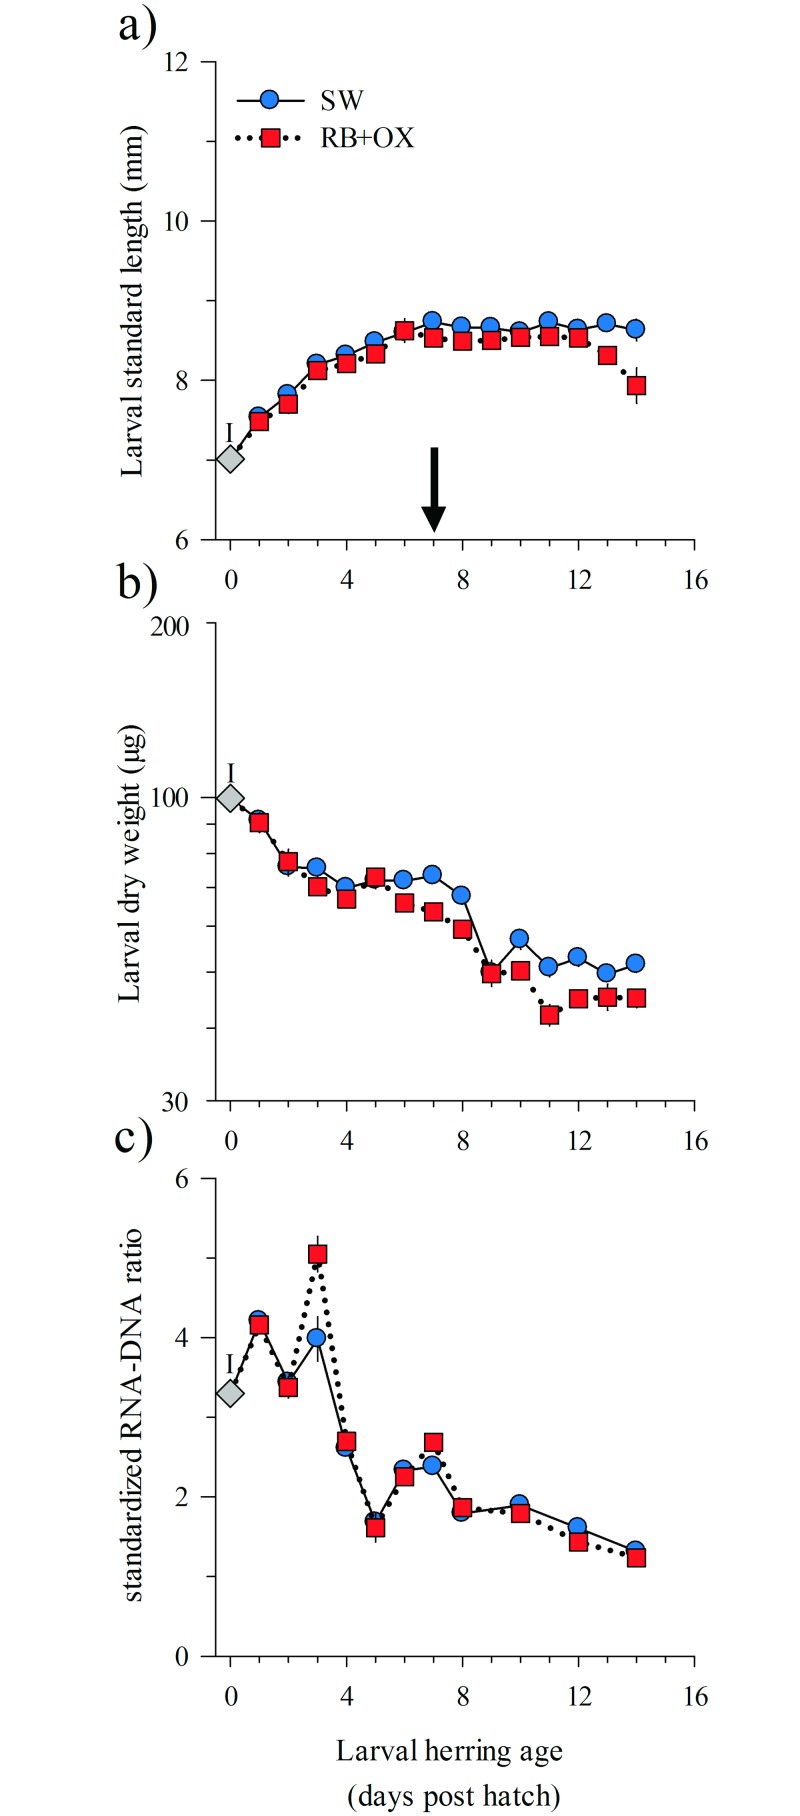
Mean (±S.E., n = 3 tanks) standard length (a), dry weight (b) and standardized RNA-DNA ratio (c) versus age (days post hatch, dph) in yolk sac larval herring (Clupea harengus) reared in the absence or presence of microalgae (RB) and protists (OX).Significant differences between treatments were observed in standard length (panel a, P = <0.001, one-way repeated measures ANOVA on ranks) and dry weight (panel b, P = <0.001, one-way repeated measures ANOVA). The black arrow indicates the age of complete yolk absorption. The letter ‘I’ represents the initial (common) measurement at 0 dph.